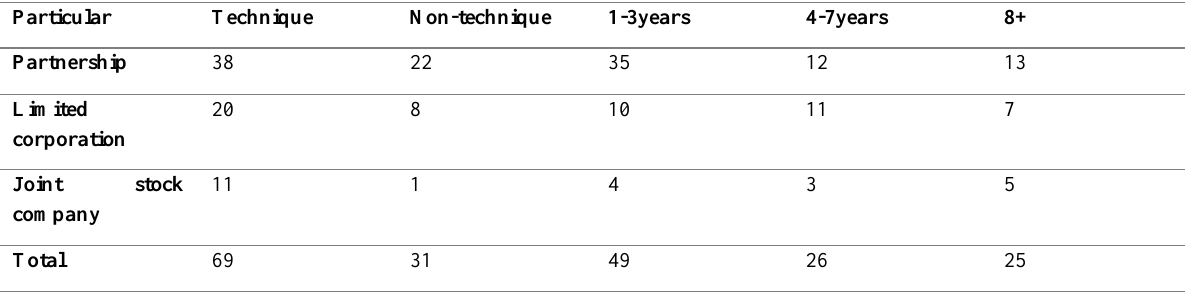
Table 7: Type of techniques used and years of operation